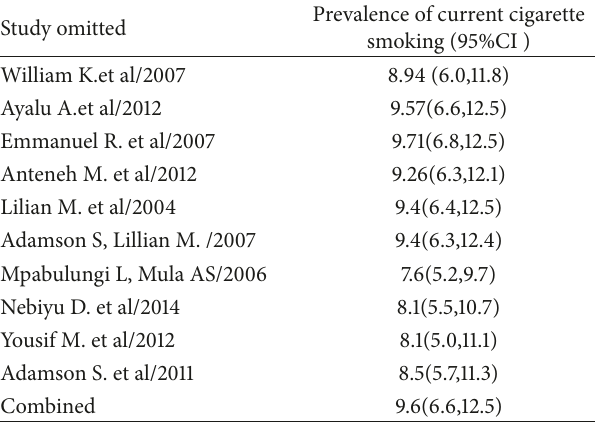
Table 2: Sensitivity analysis of the prevalence of cigarette smoking among school-going